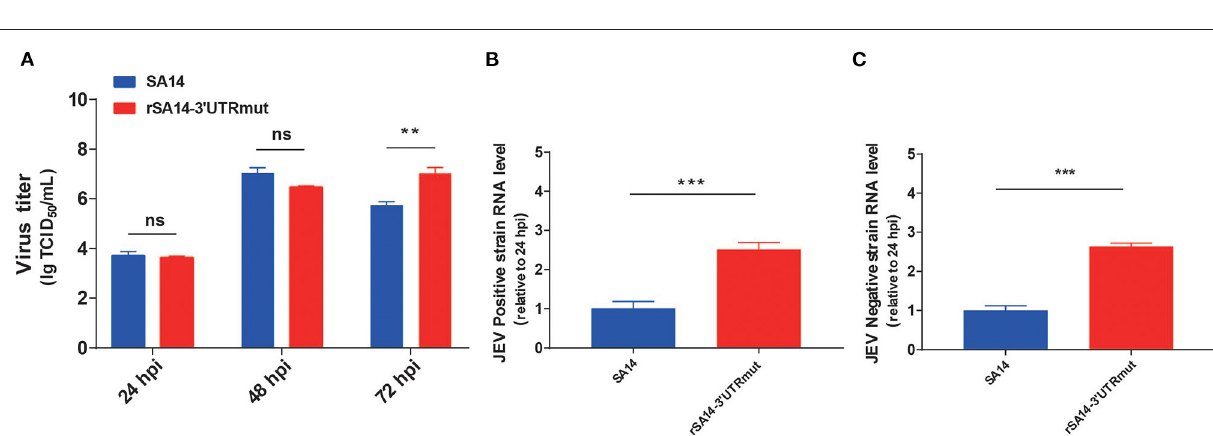
FIGURE 3 | Virus replication of SA14 and rSA14-3 ′ UTRmut. (A) BHK-21 cells seeded in 12-well plates were infected with rSA14-3 ′ UTRmut or parental virus SA14 at a MOI of 0.001. Culture supernatant was then collected at 24, 48, and 72 hpi and subjected to TCID 50 on BHK-21 cells. BHK-21 cells were infected with viruses at a MOI of 0.001, and then cells were harvested to extract total RNA. The obtained RNA was subjected to specific reverse transcription of the positive and negative strands, respectively. The viral positive strands (B) and negative strands (C) RNA levels were measured using a one-step real-time reverse transcription (RT)-PCR. Data are shown as means ± SD ( n = 3), and significance was calculated using an unpaired t -test ( ** P < 0.01; *** P <